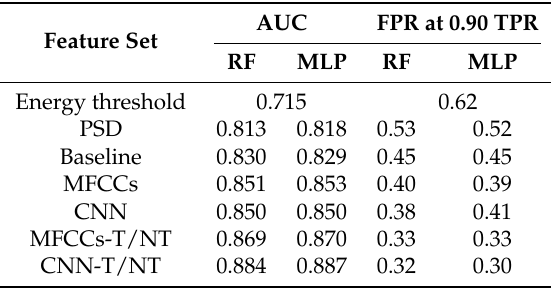
Table 3. Area Under the Curve (AUC) and False Positive Rate (FPR) at a 0.90 True Positive Rate (TPR) for the seven feature sets and two classifiers: Random Forest (RF) and Multi-Layer Perceptron